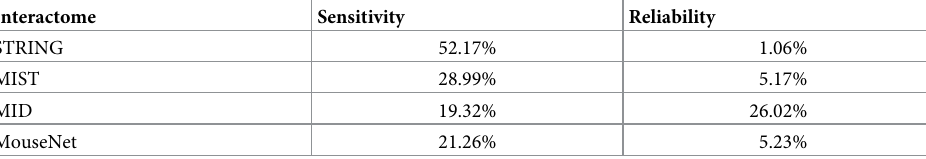
Table 1. Evaluation of the predicted interactions in available mice